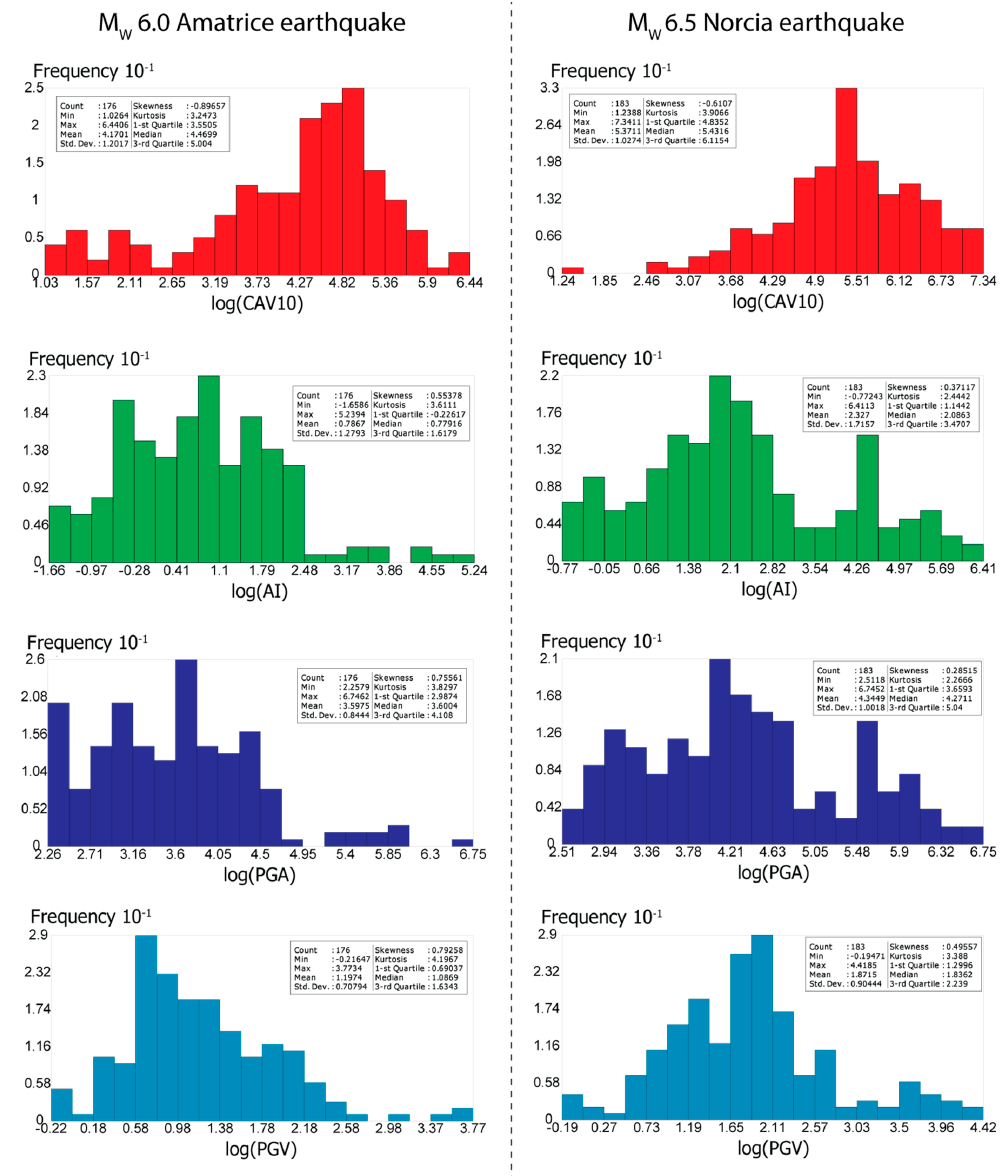
Figure 2. Histograms of the engineering ground-motion parameters for M W 6.0 Amatrice earthquake ( left panel) and M W 6.5 Norcia earthquake ( right panel ): standard cumulative absolute velocity with acceleration threshold of 10 cm/s 2 (red bars), Arias intensity (green bars), peak ground acceleration (blue bars), and velocity (cyan bars). A natural logarithmic transformation was applied to all data.